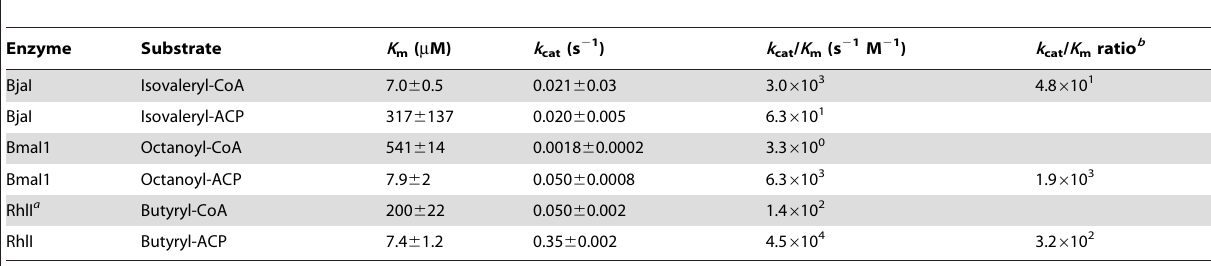
Table 1. Kinetic constants for members of the acyl-HSL synthase family.